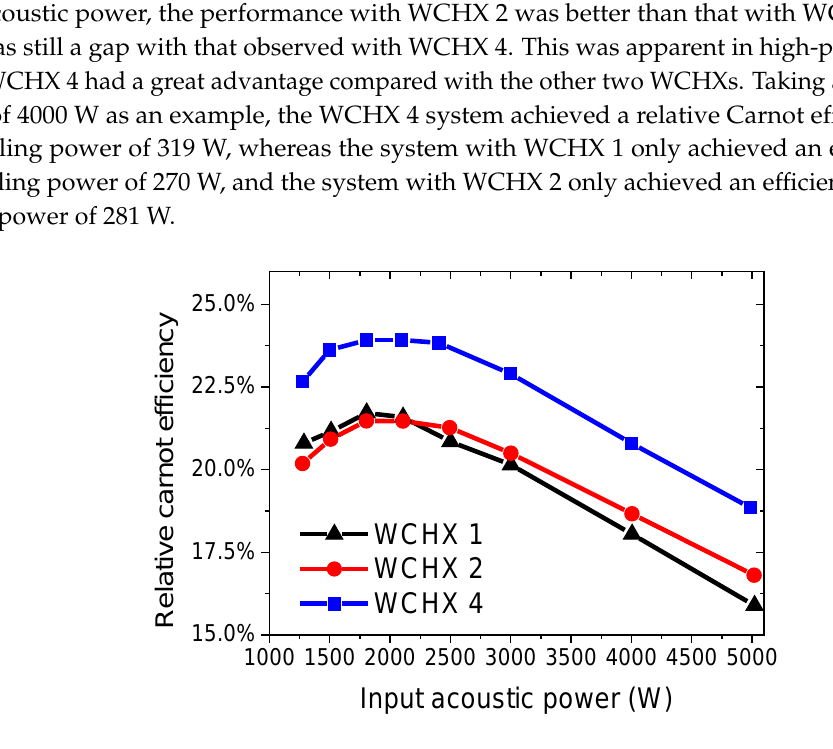
Figure 4. Dependence of relative Carnot efficiency on input acoustic power for WCHXs 1, 2, and 4.